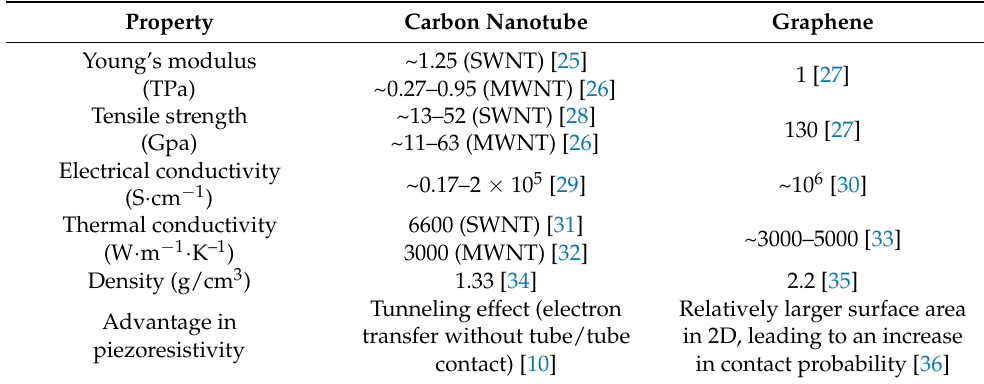
Table 1. Comparisons of CNT and graphene materials in terms of their mechanical/electrical properties and advantageous aspects of piezoresistive